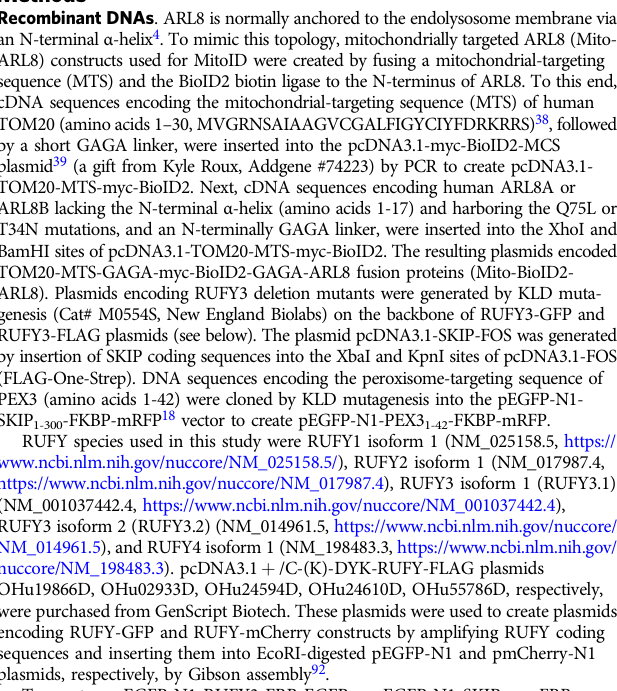
Fig. 7 Interaction of RUFY3 and RUFY4 with dynein-dynactin. a HEK293T cells were transfected with plasmids encoding GFP (negative control), GFP- BICD2 (positive control), RUFY3-GFP or RUFY4-GFP. Cell extracts were analyzed by immunoprecipitation (IP) with antibody to GFP, followed by immunoblotting (IB) for endogenous dynein intermediate chain (DIC) and endogenous p150 Glued subunit of dynactin. Ponceau S staining shows the levels of immunoprecipitated GFP-tagged proteins. The experiment shown in this panel is one of two with similar results. b Extracts of HEK293T cells were incubated with recombinant 6His-StrepII-sfGFP (abbreviated 6His-GFP in the fi gure) (negative control), His6-StrepII-sfGFP-BICD2 25-400 (His6-GFP- BICD2 25-400 ) (positive control) or 6His-StrepII-sfGFP-RUFY3 (6His-GFP-RUFY3), pulled down (PD) with Strep-Tactin agarose, and immunoblotted for endogenous dynein intermediate chain (DIC), the endogenous p150 Glued of dynactin, or GFP. The GFP used to make these constructs is a variant named sfGFP, for super-folder GFP. The experiment shown in this panel is one of two with similar results. c Glutathione-Sepharose preloaded with puri fi ed, recombinant GST (negative control), GST-DLIC1 or GST-DLIC1-CT (C-terminal domain) was incubated with puri fi ed, recombinant 6His-StrepII-sfGFP- RUFY3 (6His-GFP-RUFY3). Bound proteins were detected by immunoblotting with antibodies to GFP and GST. The positions of molecular mass markers (in kDa) in panels a-c are indicated at left. d Live-cell images of HeLa cells co-expressing RUFY3-mCherry or RUFY4-mCherry (magenta) without or with GFP-p150 Glued -CC1 (green). Single-channel images are shown in grayscale. Scale bars: 10 μ m. Arrows point to RUFY proteins at cell tips. This experiment is one of two with similar